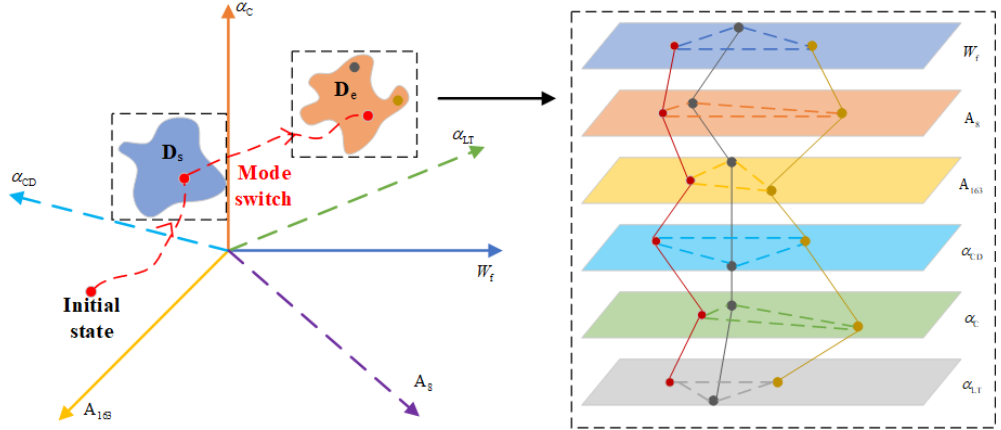
Figure 4. Schematic diagram of feasible switching domains of control variables.